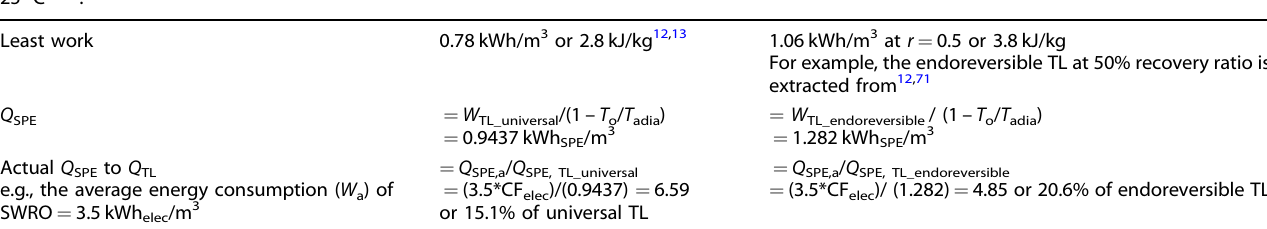
Table 3. The comparison between the universal and endoreversible thermodynamic limits. Salinity of normal seawater at 3.5% by weight and 25 o C 12,13